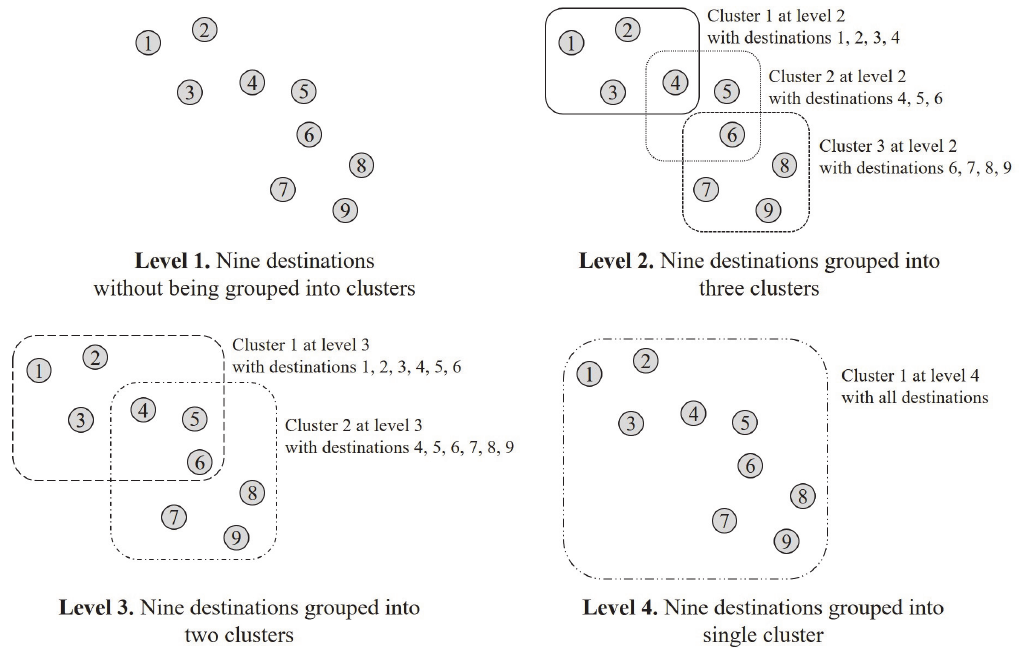
Fig. 1. 4-level Non-exclusive AHCS for an example truck loading